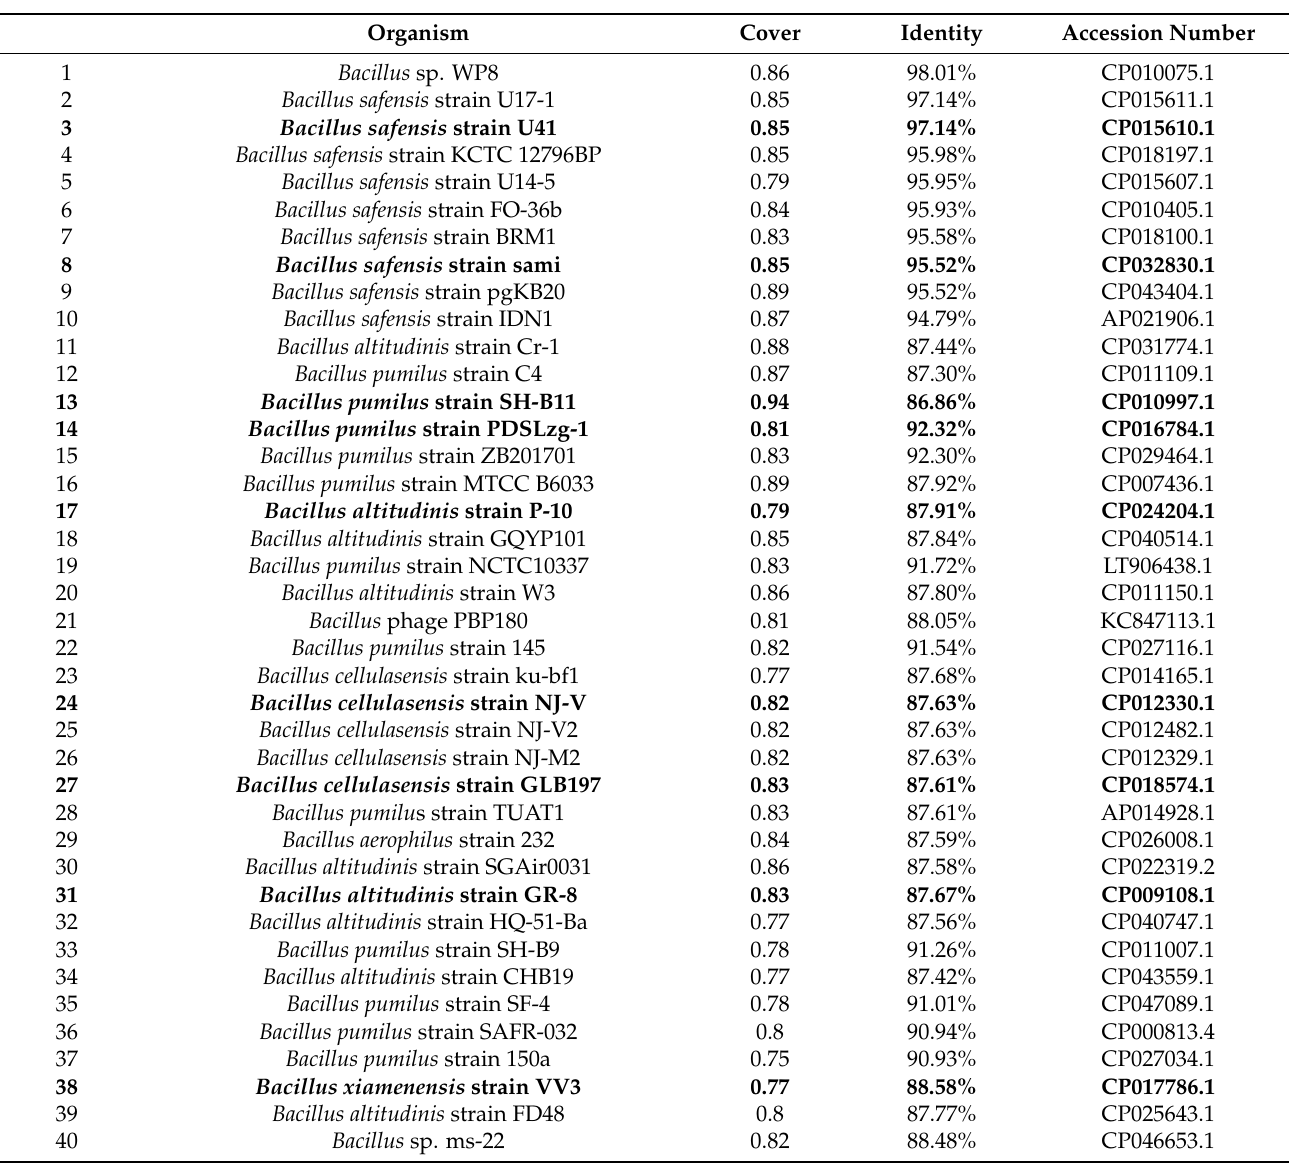
Table 2. Strains and accession number of the highest hits were obtained to compare the 28.7 kb region from B. pumilus 15.1 with sequences at the Genbank. The coverage and identity of the found regions are also indicated. Genomes selected for whole-genome dot-plot comparison are shown in